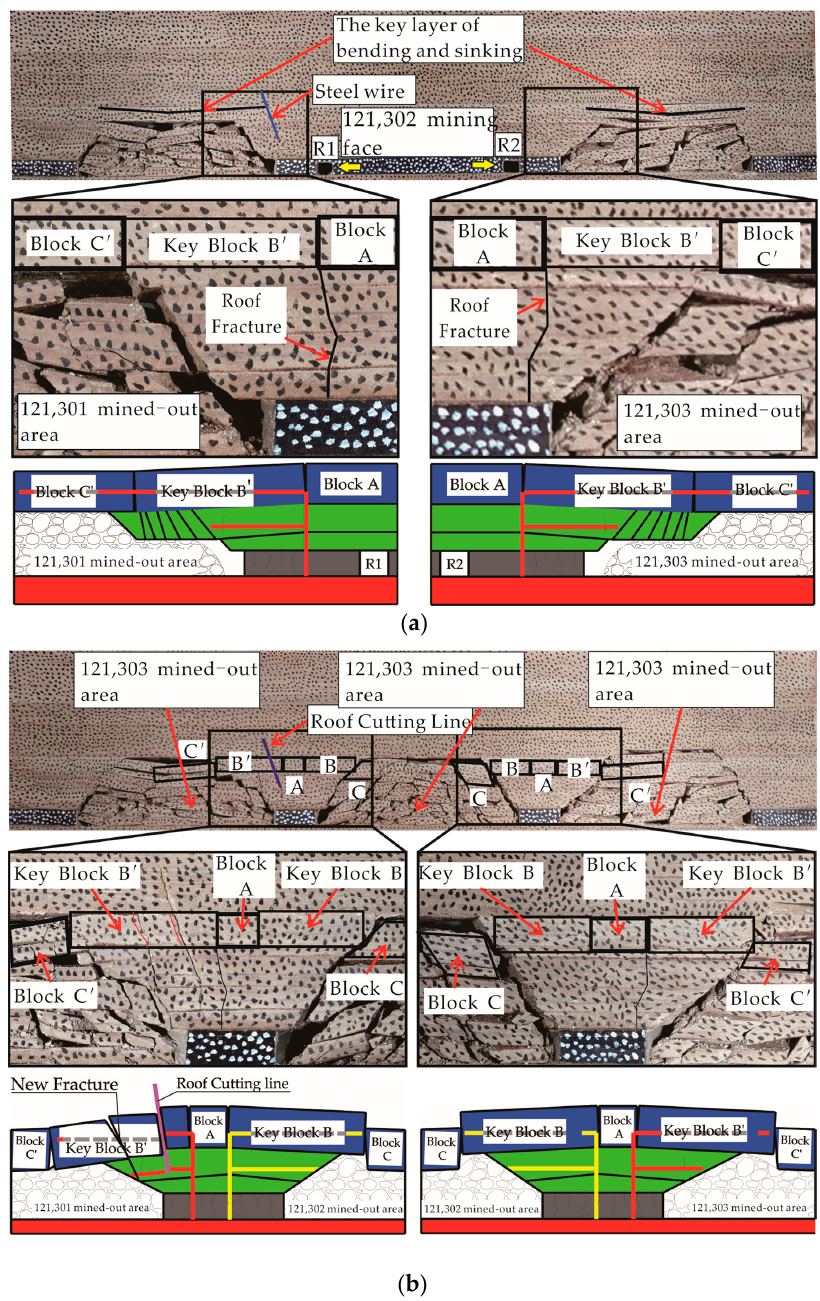
Figure 4. Layout of the overlying strata migration law for the roadway near goafs (RNG). ( a ) Long-arm “F”-type hanging roof structure. ( b ) Double short-arm “F”-type hanging roof structure.